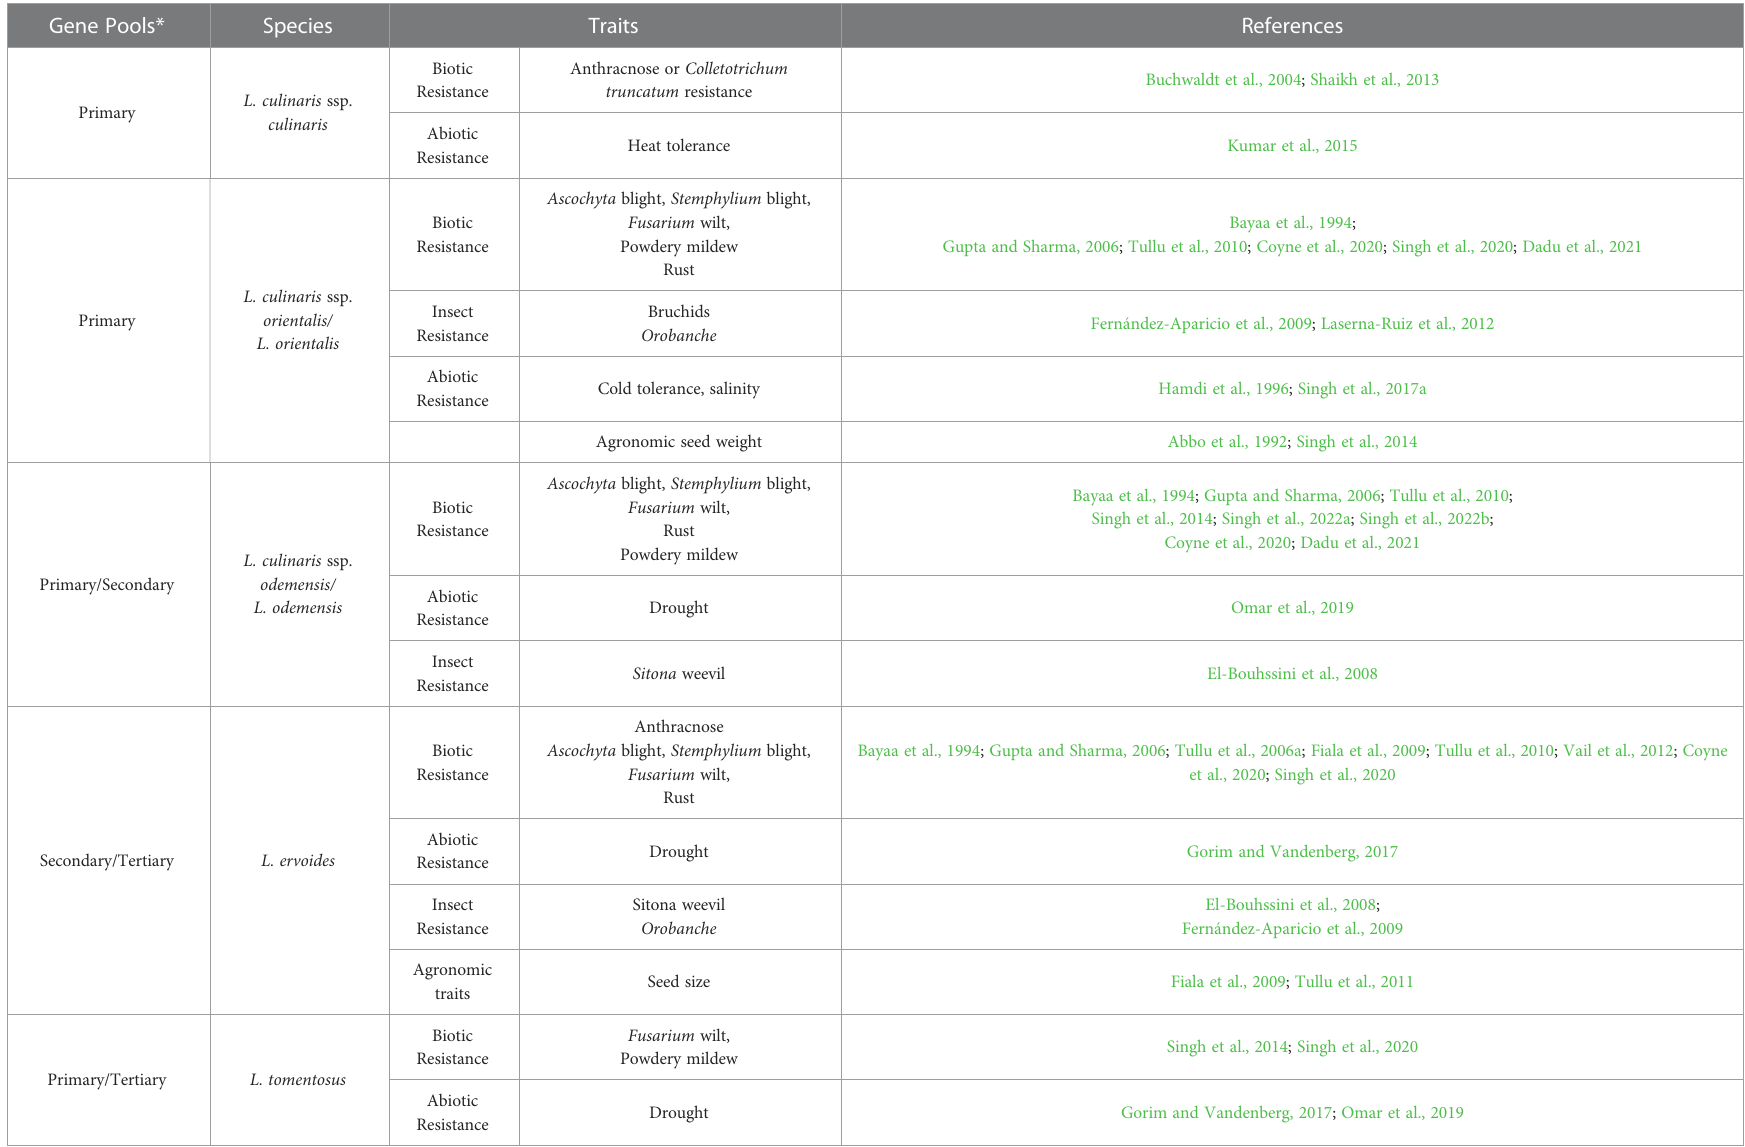
TABLE 2 Wild germplasm resources for economically important traits in